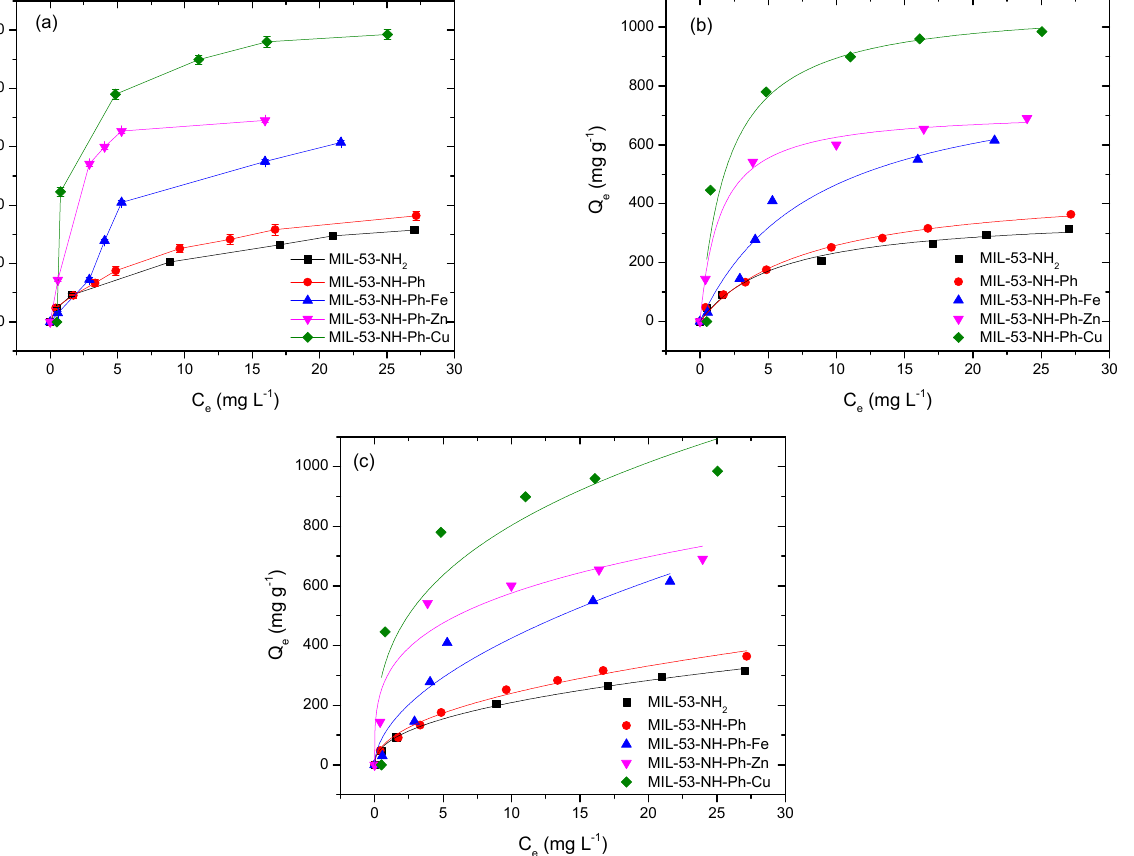
Figure 8. ( a ) Effect of carbofuran concentration on the uptake onto MIl − 53 − NH 2 , MIL − 53 − NH − ph, MIL − 53 − NH − ph − Fe, MIL − 53 − NH − ph − Zn, and MIL − 53 − NH − ph − Cu; ( b ) Langmuir isotherm fitting for the modified MIL − 53 − MOFs; ( c ) Freundlich isotherm fitting for the modified MIL − 53 − MOFs. (Dosage: 30 mg L − 1 , speed = 400 rpm, time: 120 min, pH: 7, and T = 303 k). The Langmuir model proved to be appropriate for fitting the data based on the top correlation coefficient (R 2 ) (Table 3). This relates to the pesticide carbofuran adsorption on the adsorbent, which must therefore be monolayer